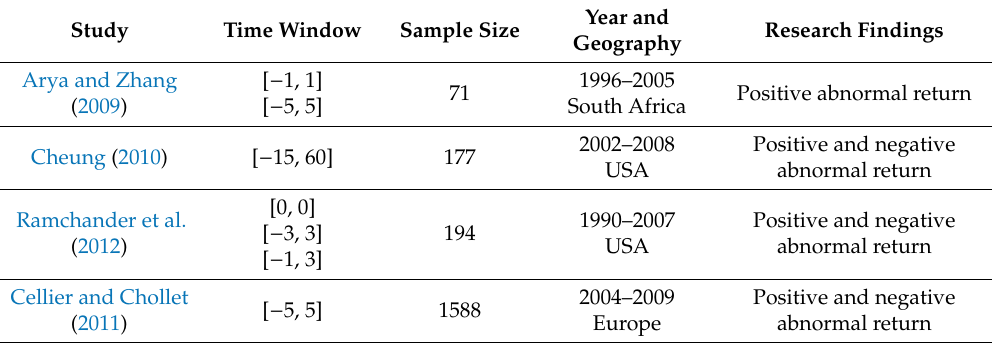
Table 3. Event studies in the category